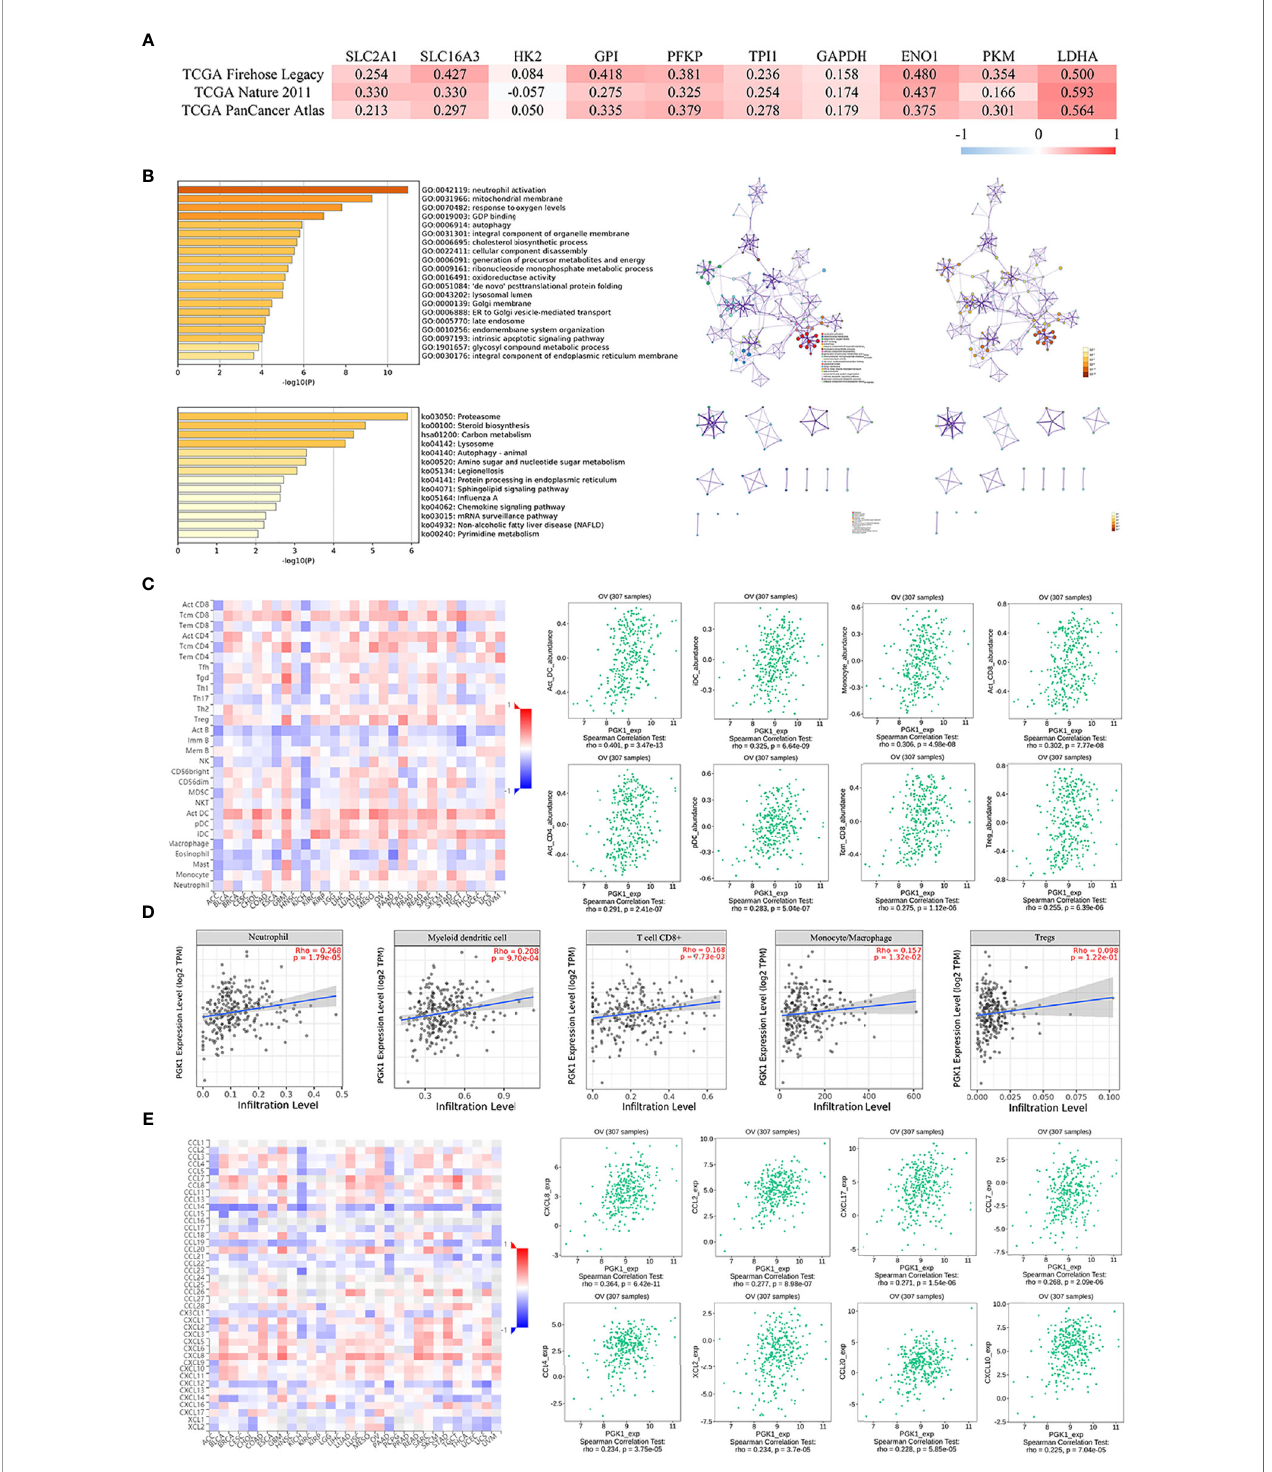
FIGURE 6 | Functional and pathway analyses of PGK1 in ovarian cancer. (A) The correlation between PGK1 and other glycolysis-related genes. (B) GO and KEGG analyses of genes interacting with PKG1 . (C) The correlation between PGK1 and immune or in fl ammatory cell in fi ltration (TISIDB database). (D) The correlation between PGK1 and immune or in fl ammatory cell in fi ltration (TIMER database). (E) The correlation between PGK1 and chemokines (TISIDB database). There is no PKM2 expression data in the cBioPortal